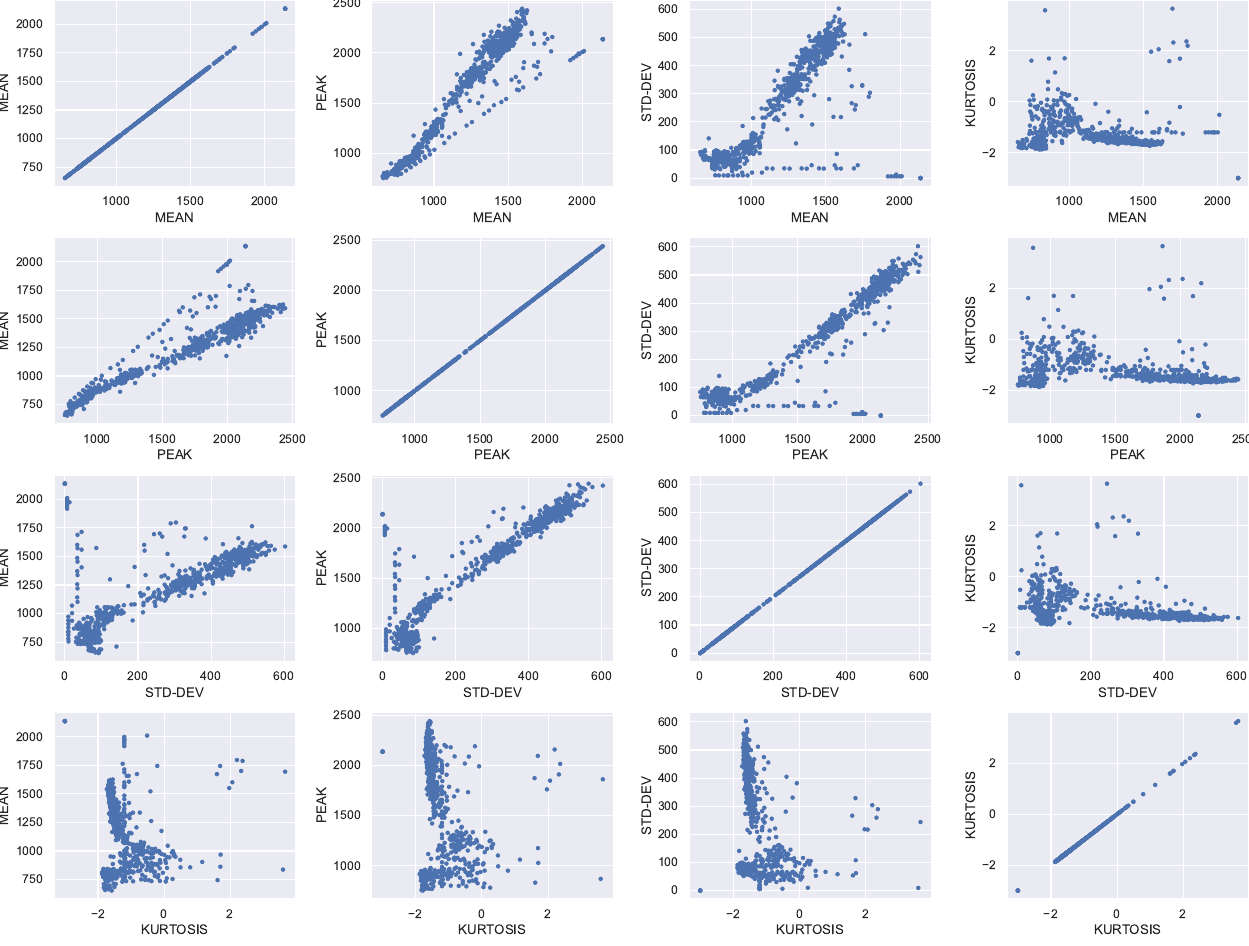
Figure 8. Correlogram of geometric